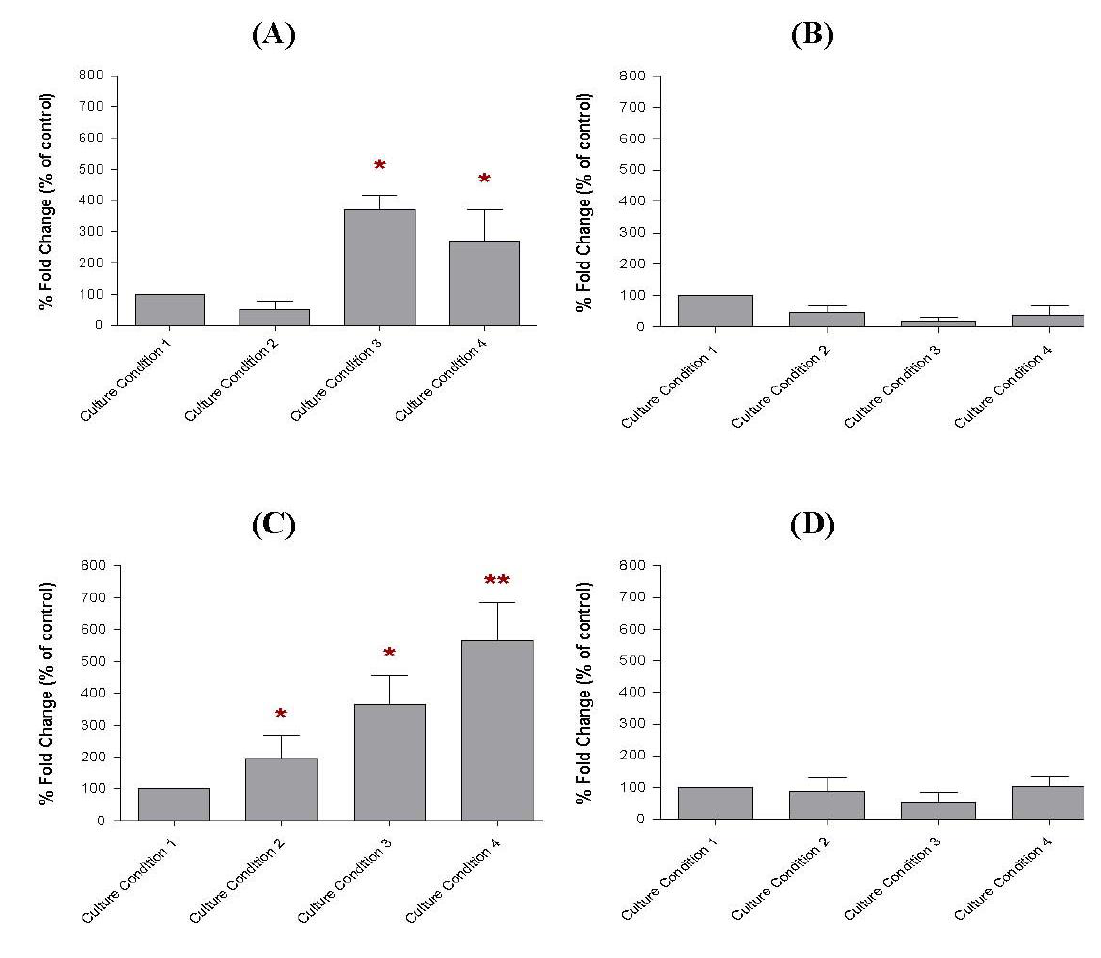
Figure 9. The transcript levels of ( A ) soluble factor a , ( B ) soluble factor b , ( C ) soluble factor c and ( D ) soluble factor d in MCF-10A cells preincubated with pioglitazone and/or serum-rich growth media. These genes’ transcripts were analysed using real-time PCR. Each value was calculated as a percentage of fold change in expression, in the preincubated MCF-10A cells. The gene transcript in the MCF-10A cells preincubated with Culture Condition 1 was defined as 100%. The values were expressed as mean ± SD from 3 replicates. * p < 0.05 and ** p < 0.01 were denoted as statistically